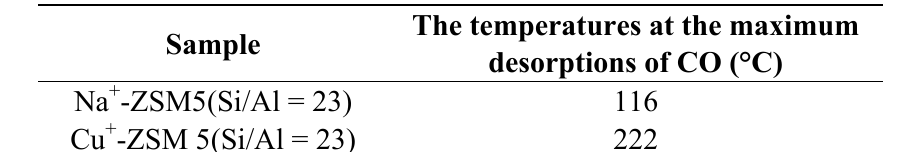
Table 4. The temperatures at the maximum desorptions of CO from Na + -ZSM5(Si/Al = 23) and Cu + -ZSM 5(Si/Al = 23).